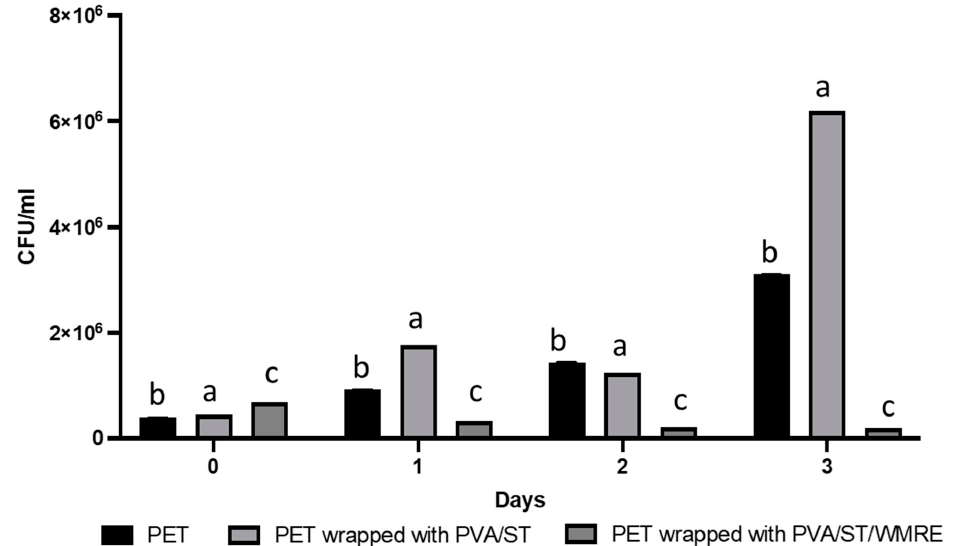
Figure 6. Microbial count, as colony forming units (CFU/mL), of fresh-cut purple cabbage under three different conditions of storage: commercial package with a lid (PET), PET wrapped with PVA/ST, and PET wrapped with PVA/ST/WMRE, while refrigerated at 4 °C. Analysis was performed on 3 consecutive days. The different letters represent a significant difference of p < 0.05. The error bars indicate the standard deviation (n = 3).